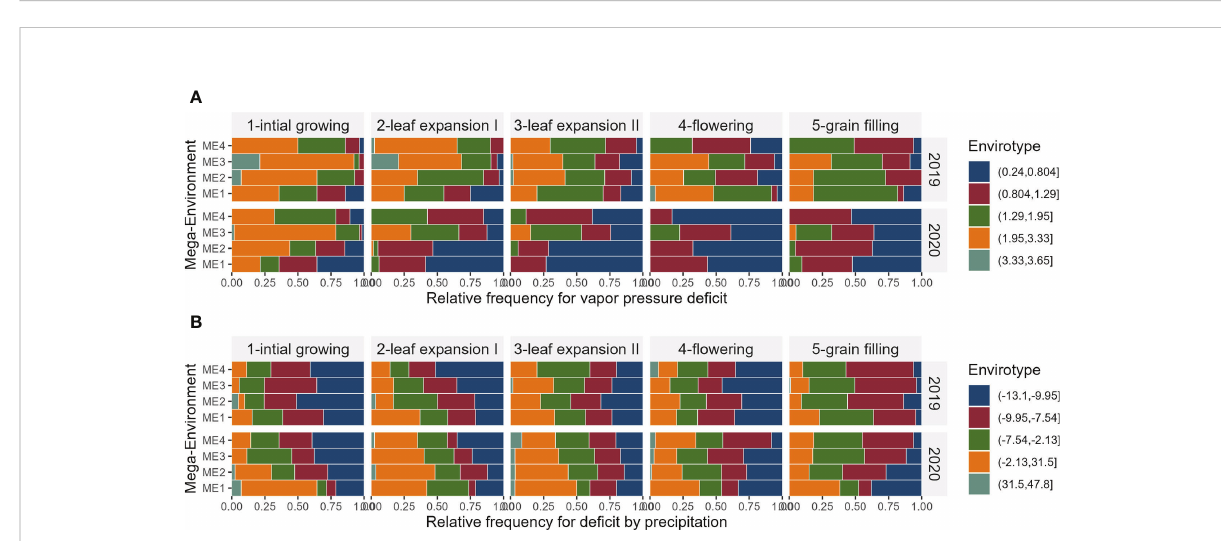
FIGURE 4 Relative frequency for each envirotype for vapor pressure de fi cit (A) and de fi cit by precipitation (B) observed in the studied and mega- environments across distinct crop stages and years of